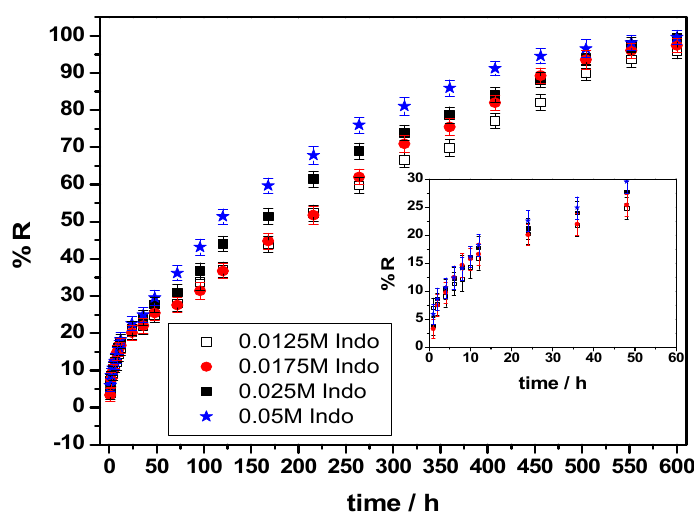
Figure 12. Indomethacin release profiles from the PPy-Indo coatings electrosynthesized on ND from ILM-ACN based electrolyte containing 0.5 M Py and various Indo concentrations. Inset: burst drug release.